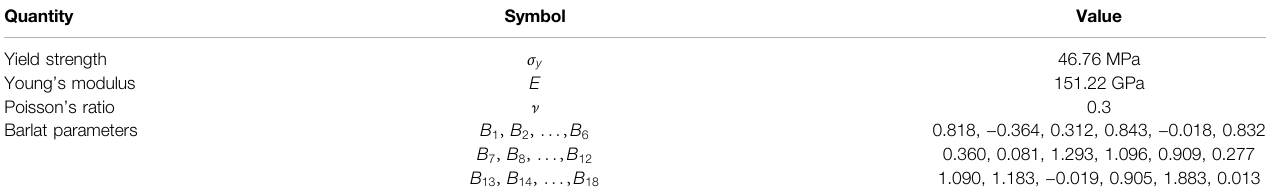
TABLE 5 | Material parameters for the Barlat-type reference material, mimicking the plastic anisotropy of a Goss-textured polycrystal. Quantity